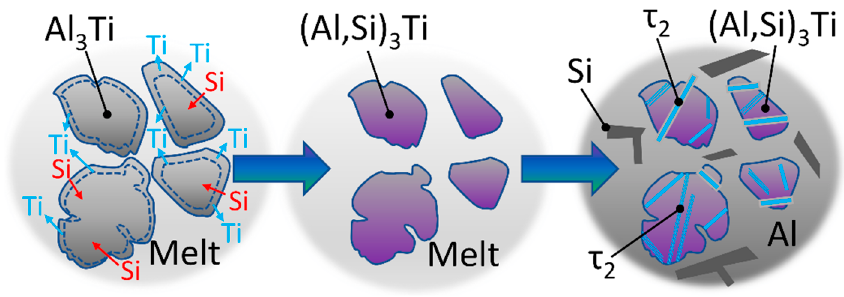
Figure 8. Transformation of Al 3 Ti particles during the A2 experiment.